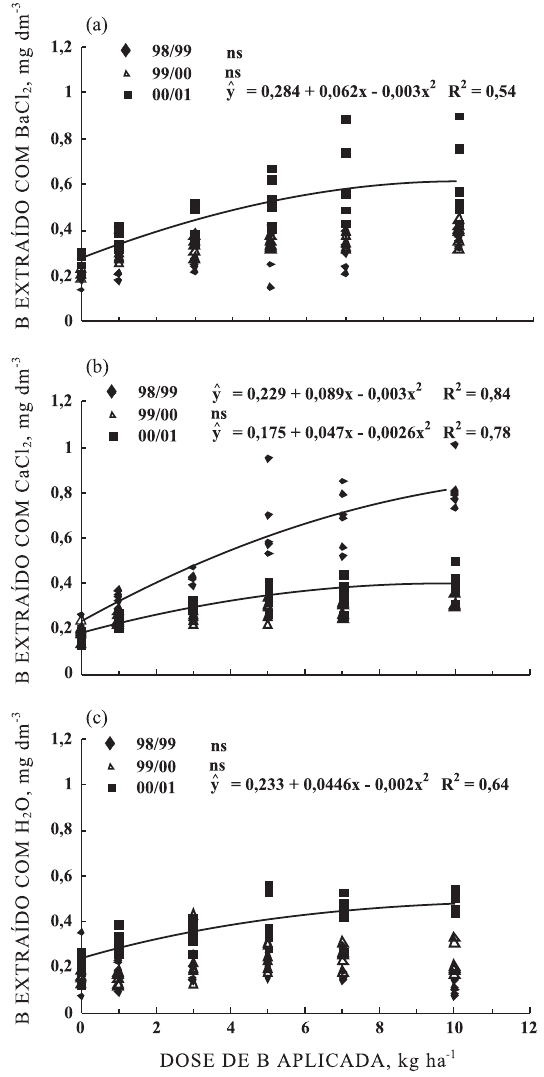
Figura 3. Teor de boro no solo em função da dose de boro aplicada no primeiro ano do